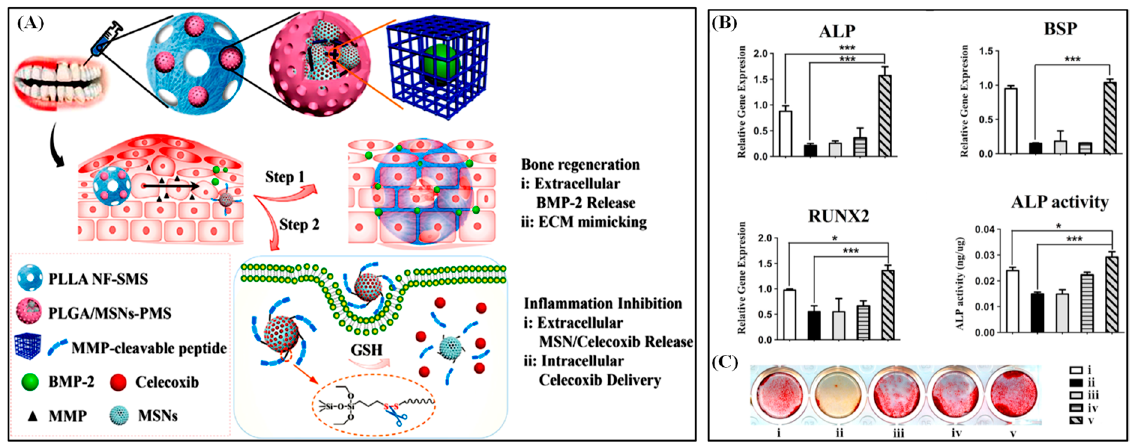
Figure 9. Schematic representation of PLGA/MSNs-PMS immobilized PLLA spongy nanofibrous micro-scaffold and dual responsive bio-molecules delivery designed complex ( A ). The gene expression of bone-related marker ALP, BSP, and RUNX2 ( B ) and the ALP activity ( C ) of inflamed bone marrow mesenchymal stem cell cells after treatment by different formulations. Reproduced with permission from